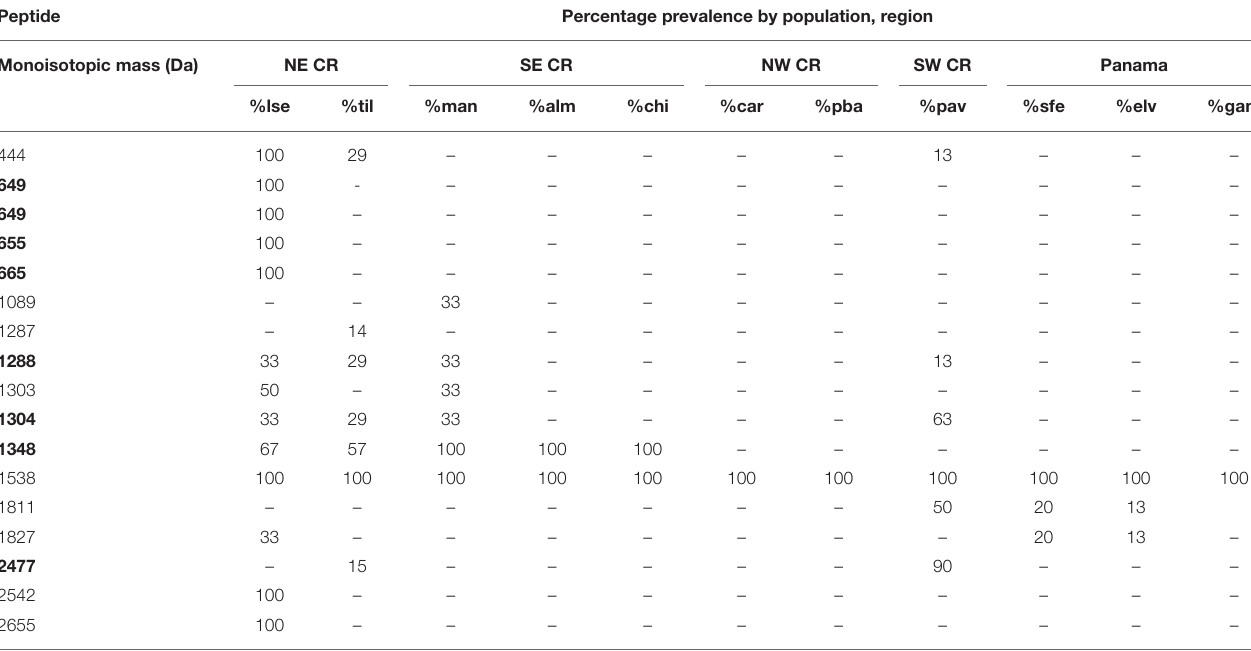
TABLE 1 | Prevalence (%) of select Agalychnis callidryas peptides detected within a population, grouped by biogeographic region in Costa Rica and Panama. Peptide